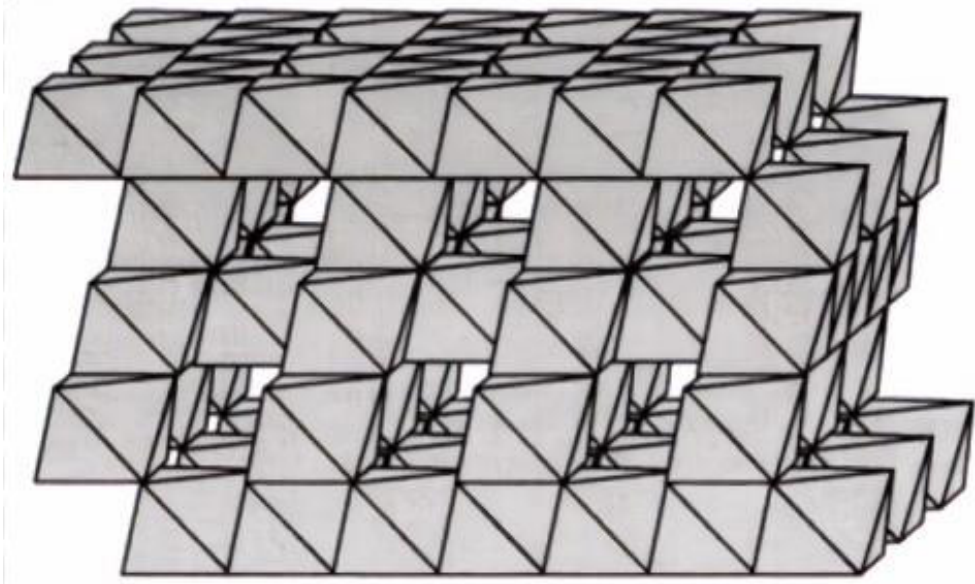
Figure 14. Structure of spinel-type manganese oxide, showing pores connecting 8a and 16c sites [139]. Republished with permission of the Royal Society of Chemistry, from Journal of Materials Chemistry, Manganese oxide porous crystals, Feng et al., v. 9(2), 319 – 333, 1999; permission conveyed through Copyright Clearance Center, Inc.